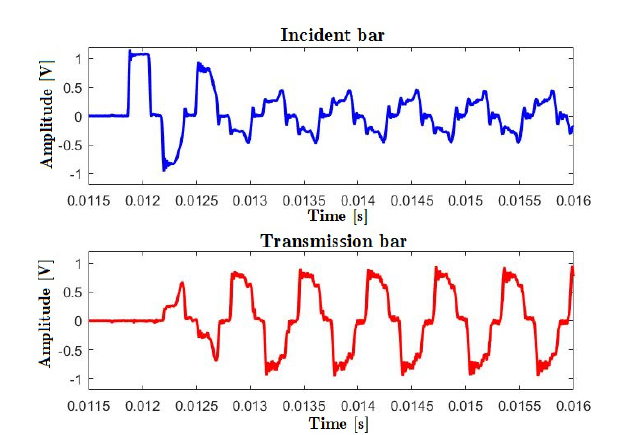
Figure 10. Measured signal from the incident and transmission bars.